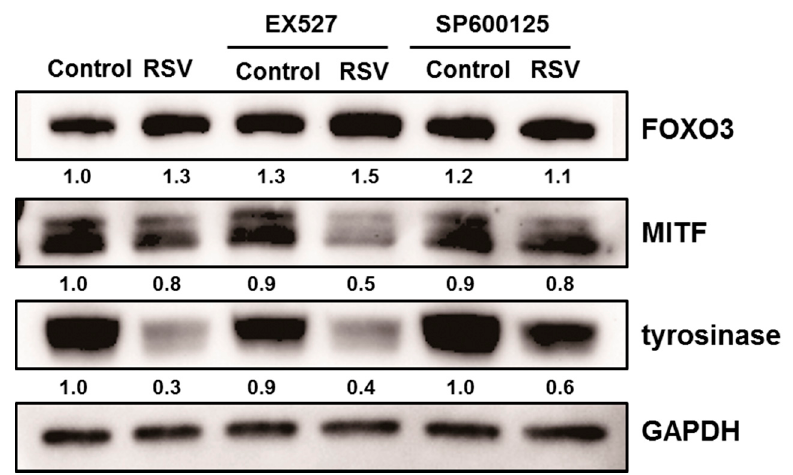
Figure 5. Normal human melanocytes were treated with resveratrol (50 μ M) after pre-treated with EX527 (SIRT1 inhibitor) and SP600125 (JNK inhibitor).